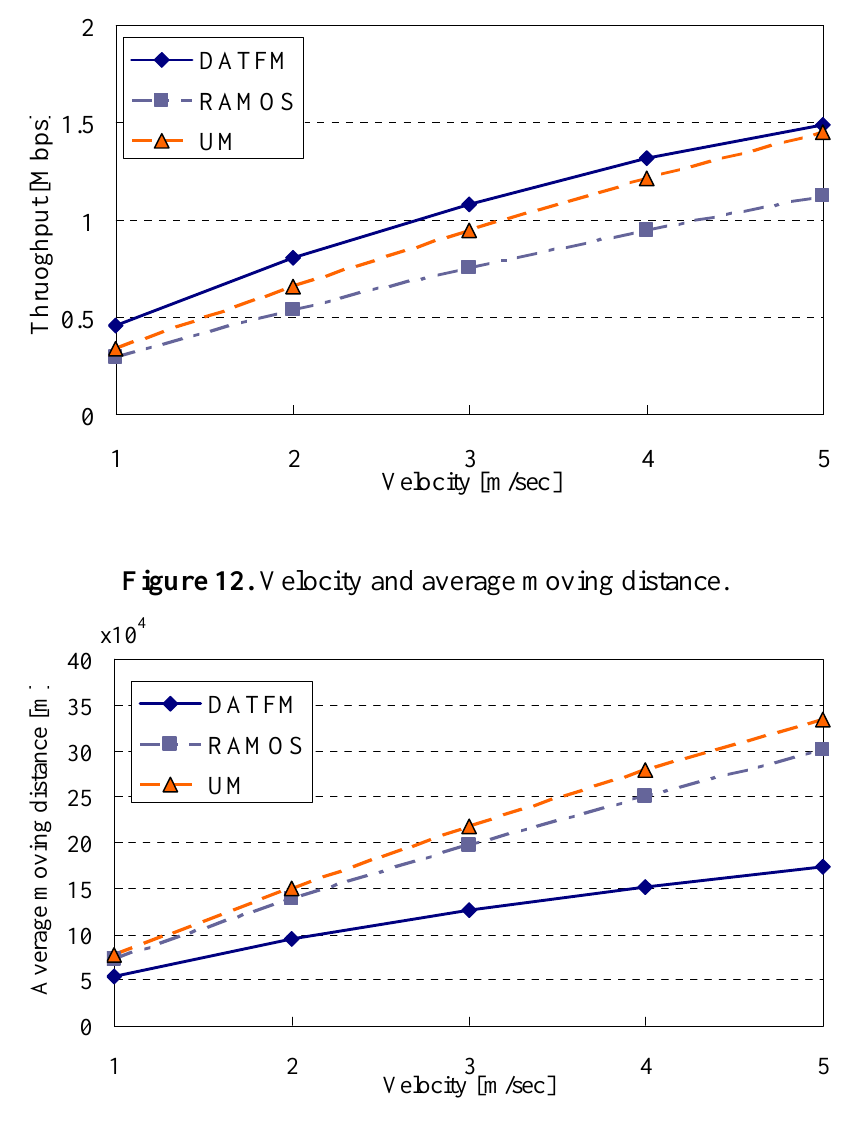
Figure 11. Velocity and throughput.